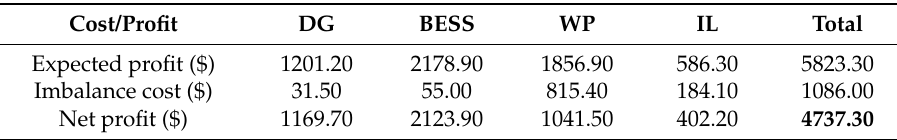
Table 2. Profits and costs for VPP components in Case 2